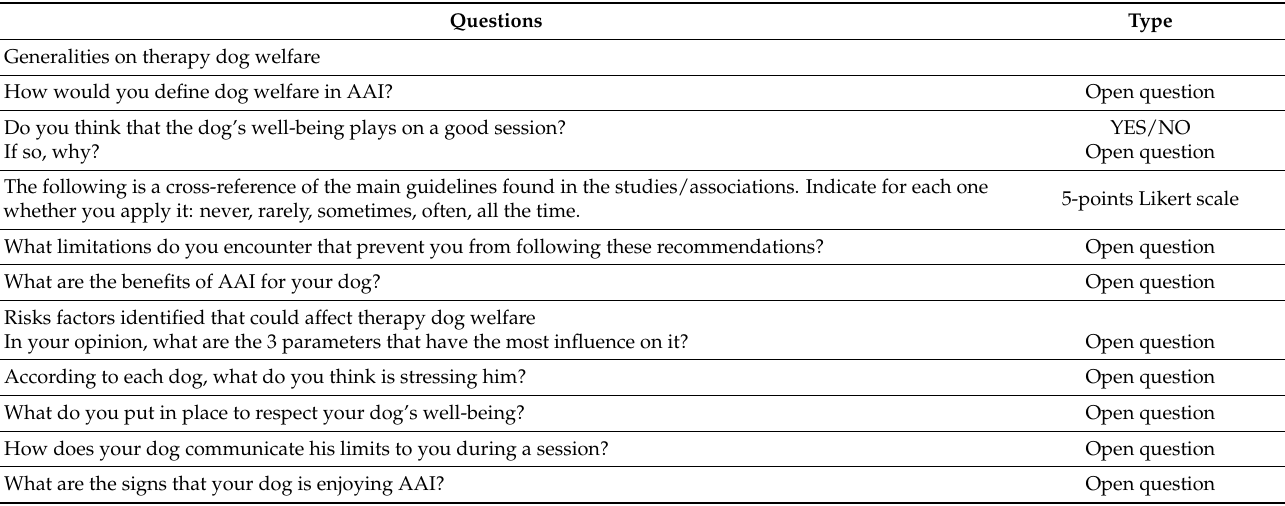
Table 1. Description of the section “dog’s welfare” of the questionnaire used in this study. Complete description of the questionnaire as a supplement data in Mignot